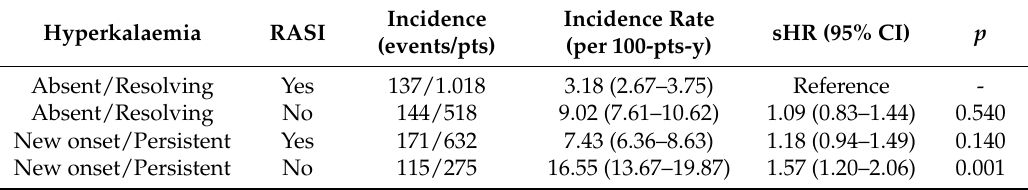
Table 4. Incidence and adjusted risk of ESKD in patients stratified in subgroups by the combination of hyperkalaemia and RASI categories over the two study